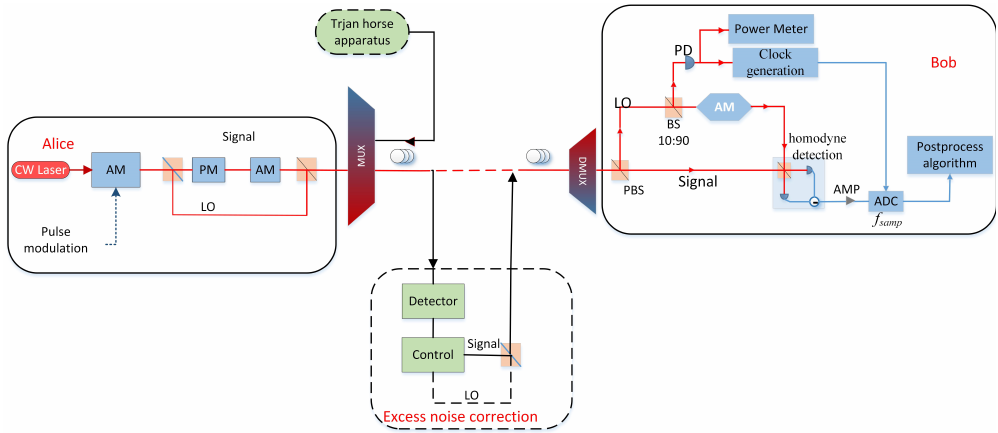
Figure 8. Schematic diagram of CV-QKD with excess noise correction. PM, phase modulation; AM, Amplitude modulation; PD, photodiode; PBS, polarization beam splitter; ADC, analog-to-digital; AMP,